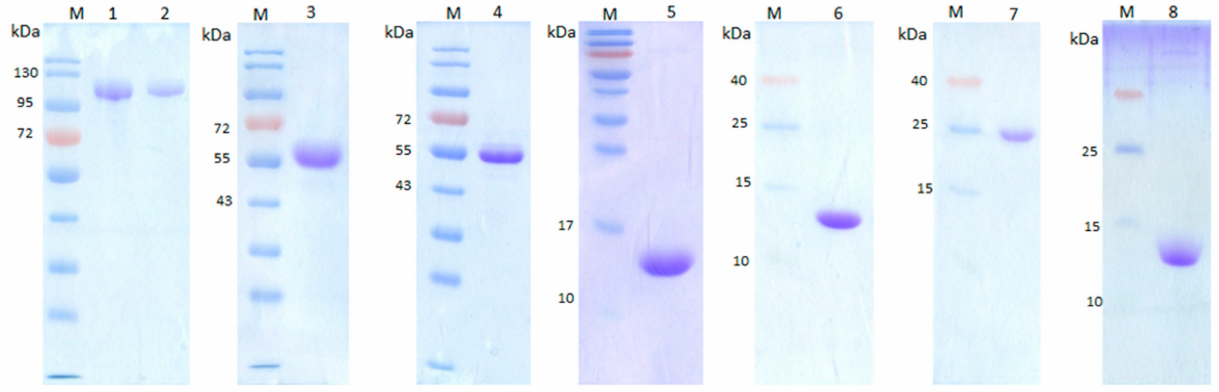
Figure 2. SDS-PAGE analysis of purified recombinant proteins. Lane 1: rsScpA, Lane 2: rsScpA193, Lane 3: Cat, Lane 4: Fn, Lane 5: PA, Lane 6: Fn1, Lane 7: Fn2, Lane 8: Fn3. M: molecular maker.